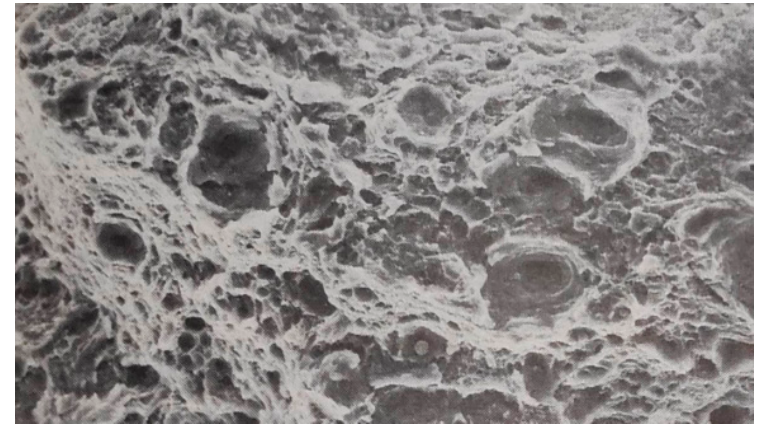
Figure 3. Fracture of the metal of the cylinders (steel 35 KhN3MFA), ×2000 [41].